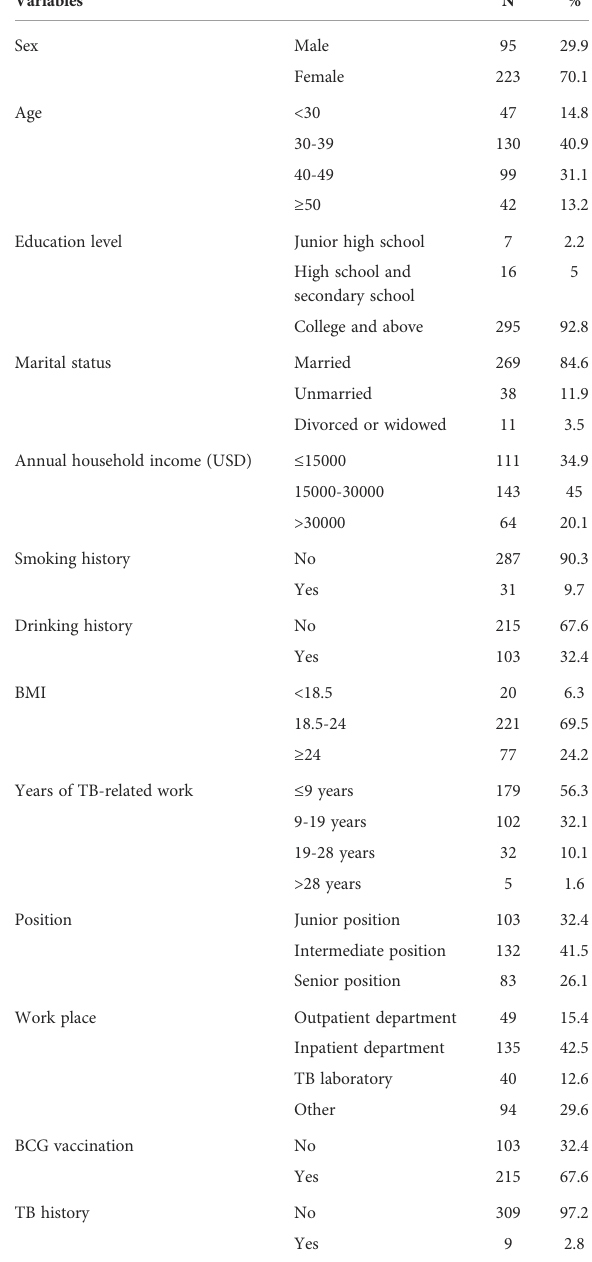
TABLE 1 Basic characteristics of TB-related health care workers in Zhejiang